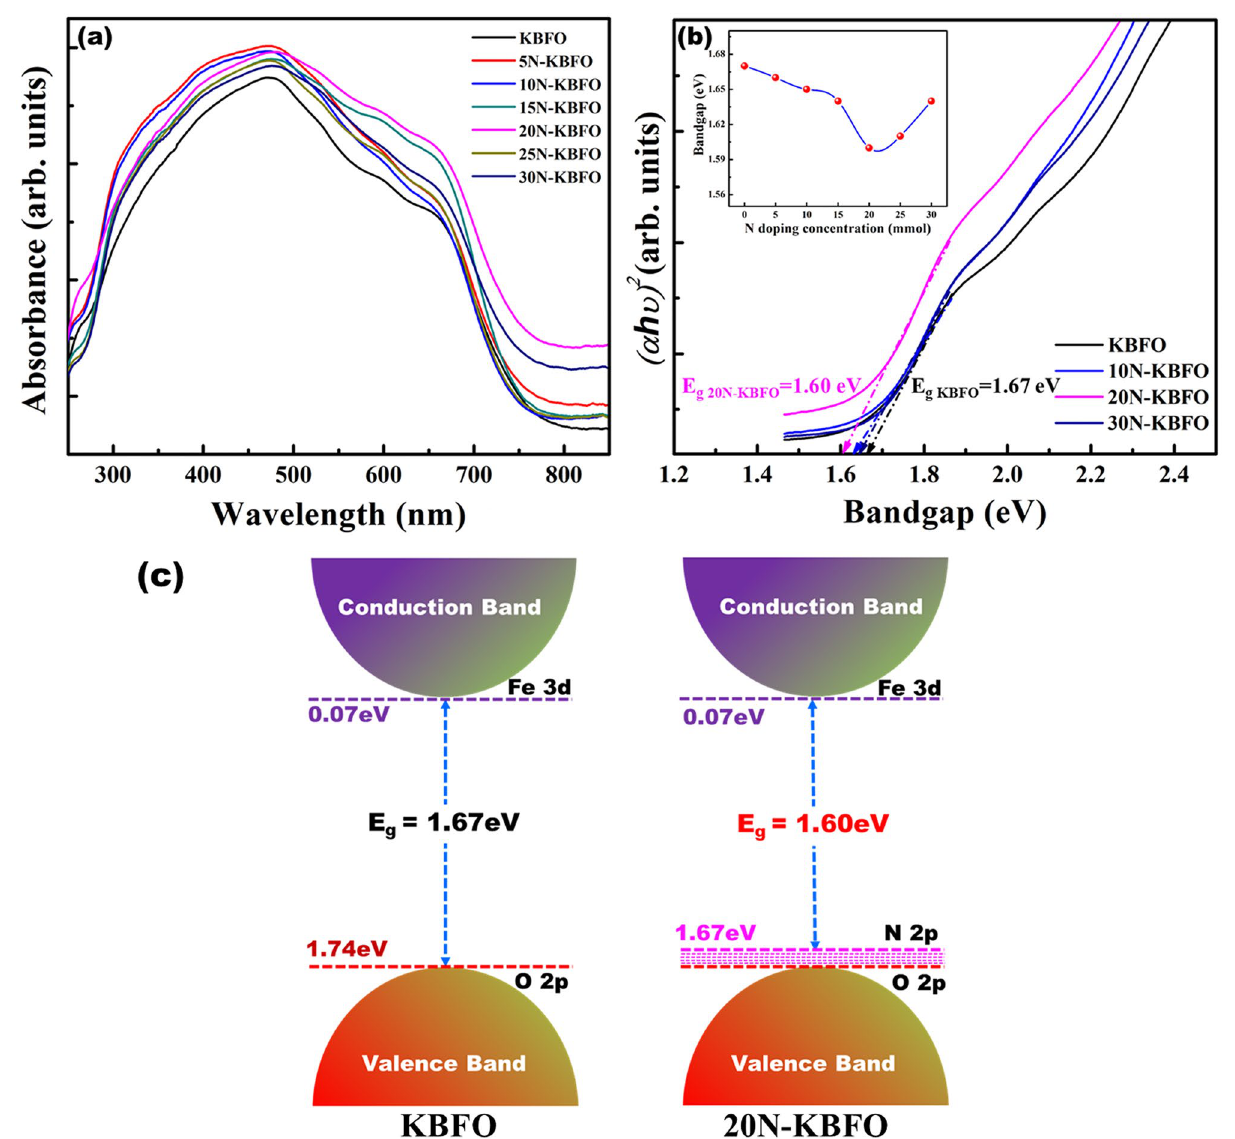
Figure 4. ( a ) UV–vis absorption spectra of KBFO with various N-doping concentrations ( b ) Tauc plots corresponding to KBFO, 10N-KBFO, 20N-KBFO, 30N-KBFO (inset shows variation of effective optical bandgap with respect to N-doping concentration) ( c ) Energy band diagram corresponding to pure KBFO and